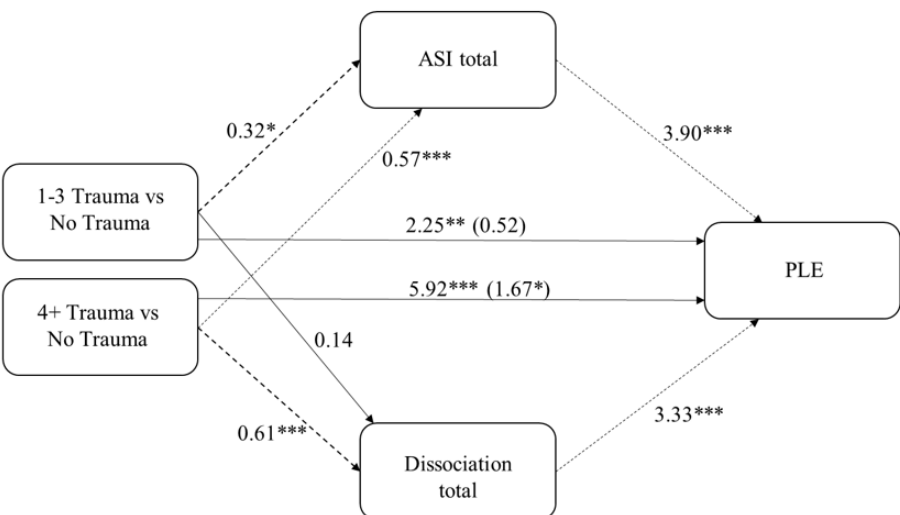
Figure 2. Multicategorical parallel mediation model of the relation between trauma and psychotic-like experiences (PLE) via Aberrant Salience Inventory (ASI) and dissociation. Note: * p < 0.05, ** p < 0.01, *** p < 0.001; unstandardized coefficients reported. Total effects for trauma, not including the mediators in the model appear outside the parenthesis. The Direct effects for trauma, including the mediators in the model, appear inside parenthesis. Mediated paths are presented as dotted lines. Model controls for age, gender, race, and income.